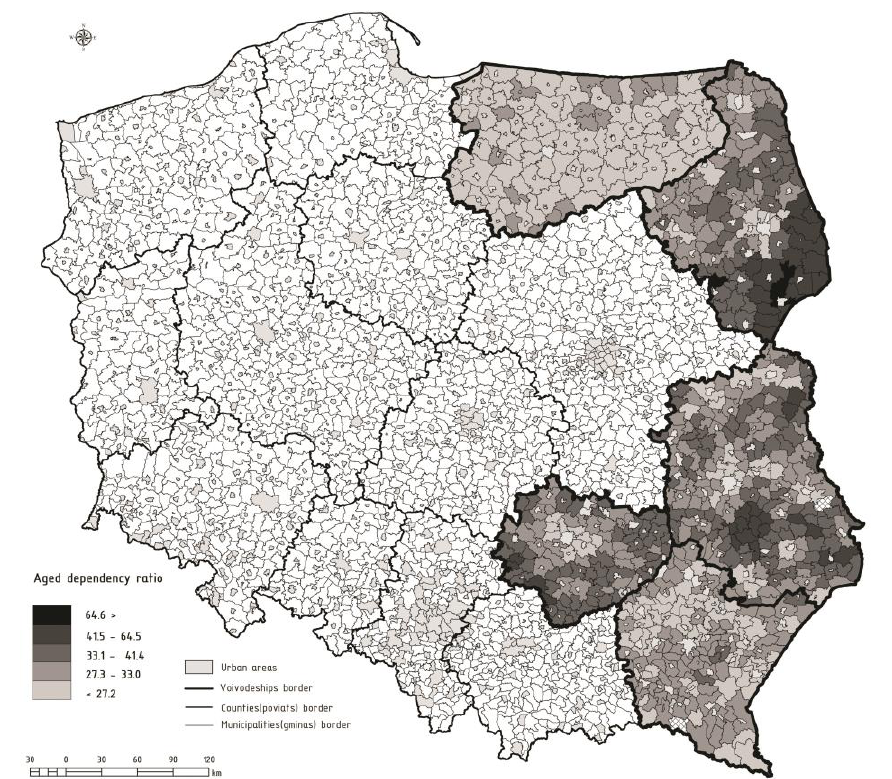
Fig. 8. Post-working age population per 100 persons of working age in rural areas of Eastern Poland in 2020 (Source: authors’ own